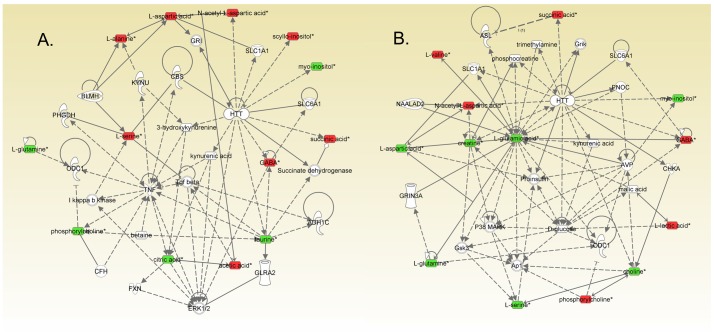
Networks associated with subchronic MK-801 treatment identified by Ingenuity Pathway Analysis.For clarity, proteins and metabolites are presented with different geometric shapes in the relevant network in cortex (A) or hippocampus (B). Metabolite symbols with red were up-regulated while green were down-regulated. Proteins and treatment unrelated metabolites are shown as clear. Dotted lines show indirect interactions or regulations between the two parties, while solid lines show direct physical interactions (such as binding) of the two parties.